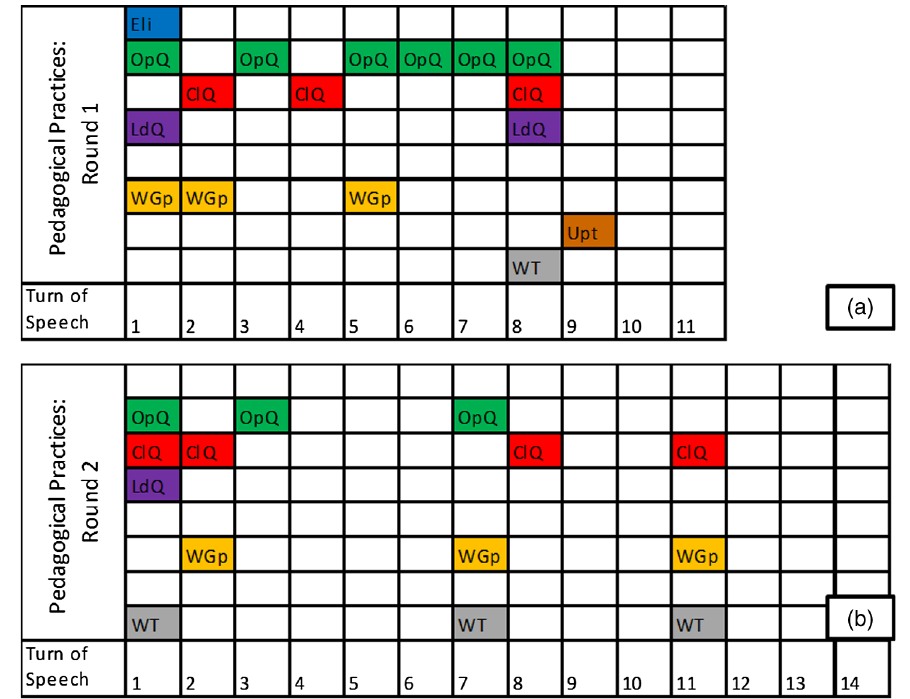
FIG. 4. Pedagogical skill use by LA-3A. This LA decreased his use of open questions, while increasing his use of wait time. The transcripts for these interactions are available in the Supplemental Material